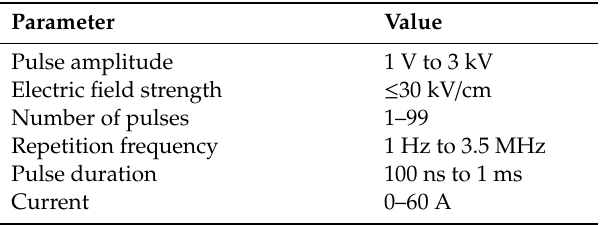
Table 1. Pulse forming circuit